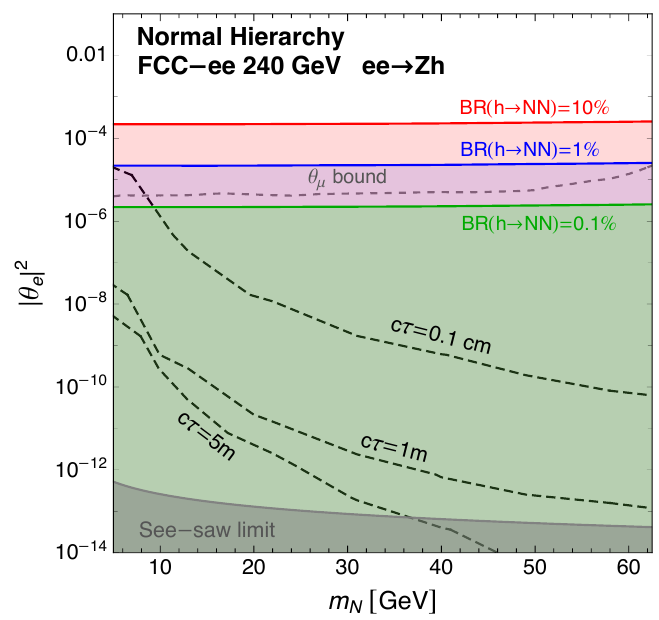
Figure 2 . Regions in the m N −| θ e | 2 parameter space where the RH neutrino pair production from the Higgs-strahlung process of eq. (4.3) is larger than the production of a single RH neutrinos via mixing, for BR( h → NN ) = 10% (red), 1% (blue) and 0.1% (green) for the FCC-ee case. The NH case is assumed. The gray dashed line represents the limit on the mixing angle arising from existing experimental searches, while the black dashed lines represent isocontour of proper decay length cτ . In the gray shaded region the lightness of the neutrino masses cannot be explained by the see-saw